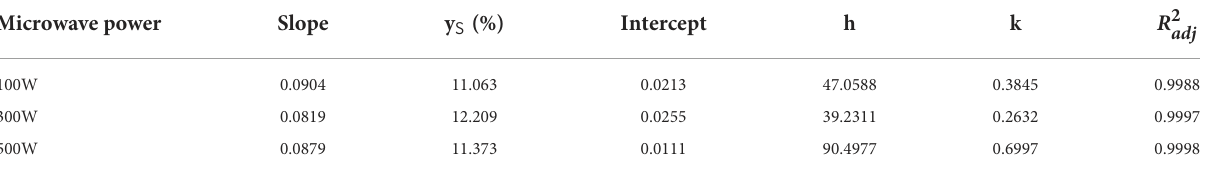
TABLE 3 Second-order kinetic model parameters for UMAE of pepper oleoresin at different microwave powers. Microwave